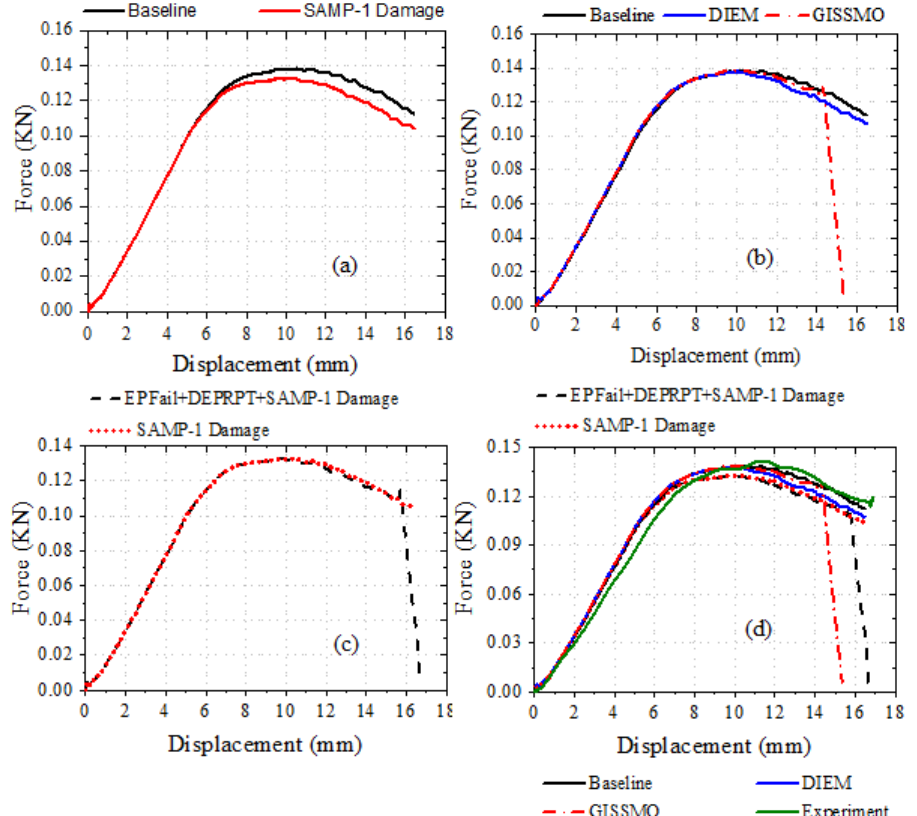
Figure 14. Comparison of force–displacement plots with different damage modeling formulations.; (a) Baseline vs Activating the inherent Samp-1 Damage, (b) Baseline vs GISSMO damage formulation vs DIEM Damage formulation, (c) Inherent Samp-1 Damage vs Activating EPFAIL and DEPRPT parameters with Inherent Samp-1 Damage, (d) Experiment vs Baseline vs Activating the inherent Samp-1 Damage vs GISSMO damage formulation vs DIEM Damage formulation vs Activating EPFAIL and DEPRPT parameters with Inherent Samp-1 Damage.